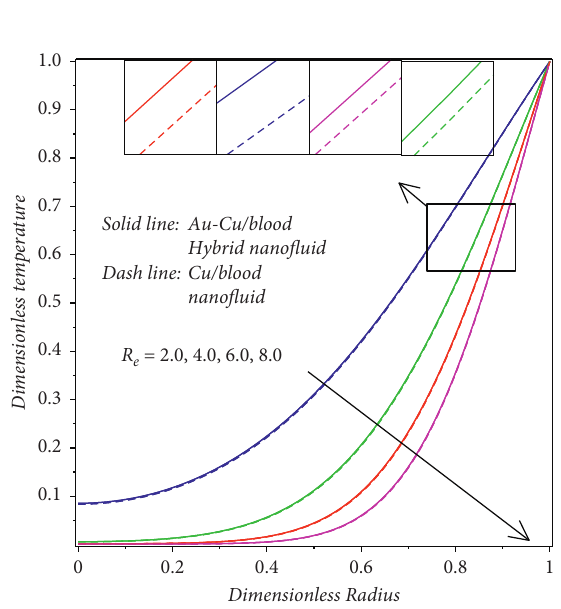
+ ϕ and ϕ on θ 1 2 2